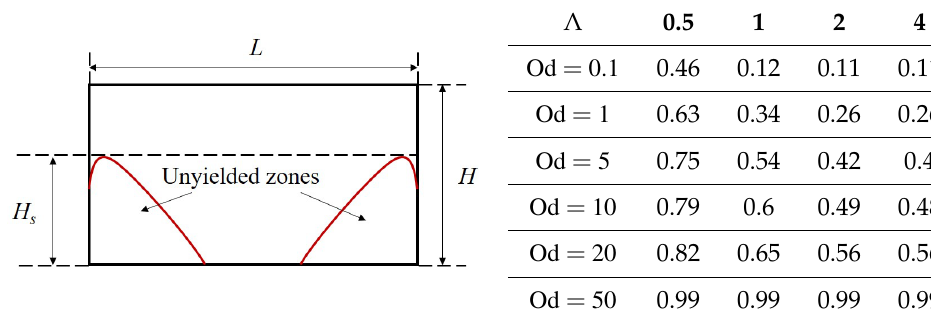
Table 2. Results for characteristic height H s / H of the dead zone with different cavity